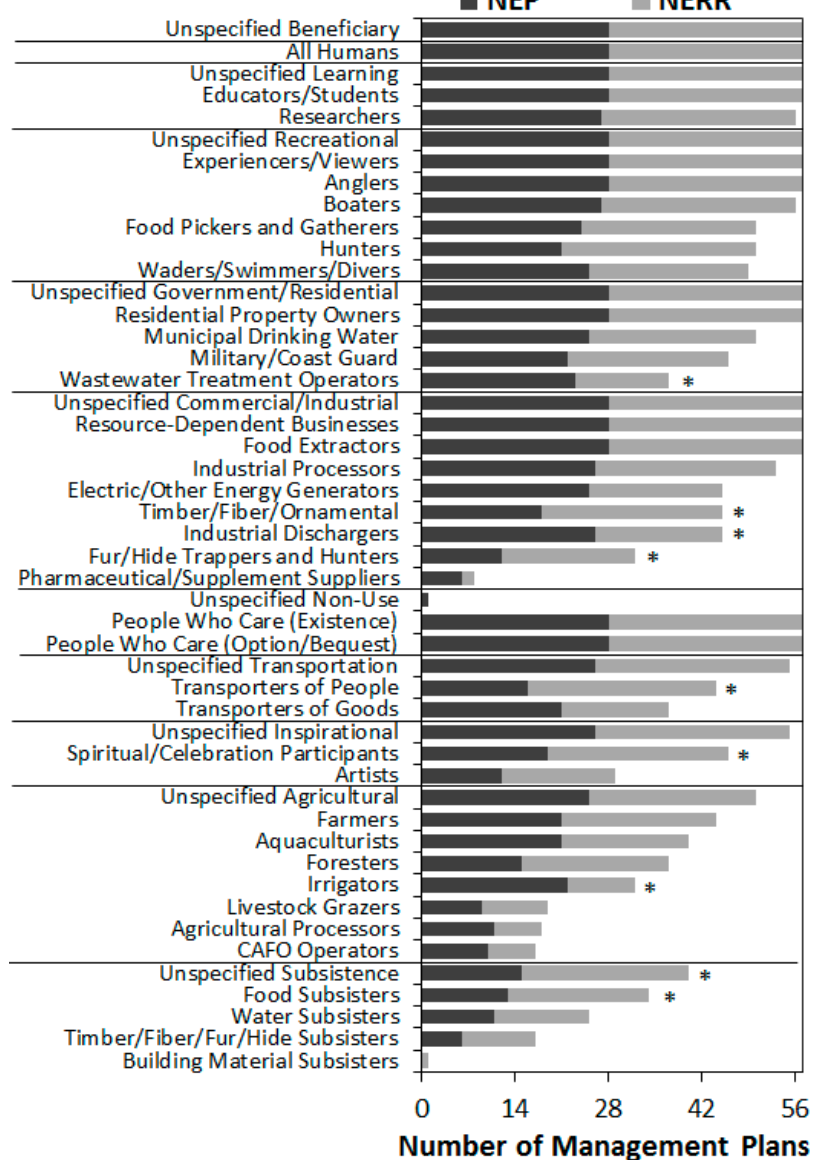
Figure 2. Number of NEP or NERR management plans mentioning each beneficiary category. Asterisks denote categories for which counts differed significantly (logistic regression; p < 0.05) between NEP and NERR.